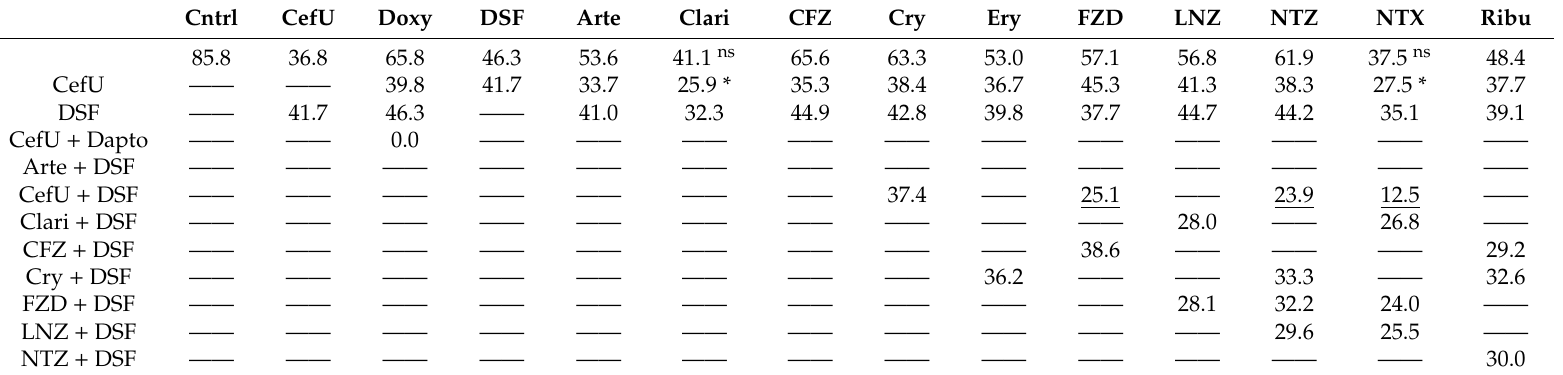
Table 2. Borrelia burgdorferi viability (in %) in a 7-day-old stationary phase culture after the drug exposure experiment for 7 days at a Cmax concentration for each drug. Results underlined were further assessed in a subculture experiment (Table 4).